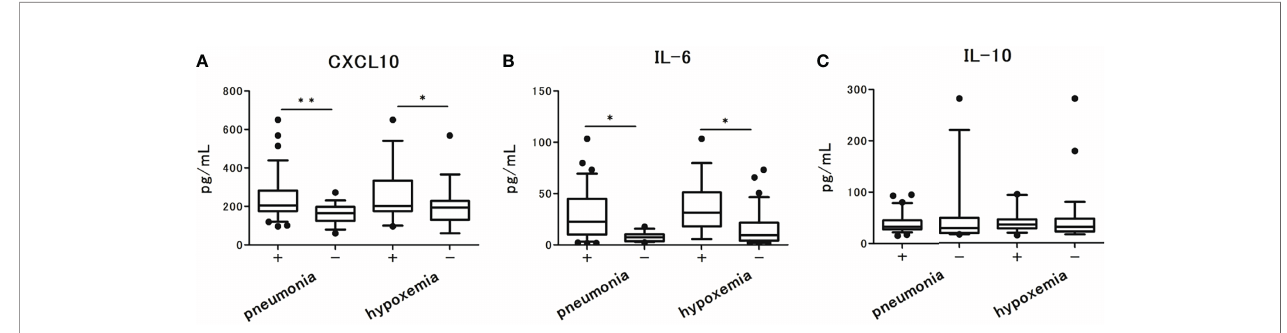
enzyme 2 (ACE-2) by using commercially available ELISA assays, according to the manufacturers ’ instructions ( Supplementary Table 1 ): TNF- a , IL-17, and VEGF (Chondrex, Washington, USA) and ACE-2 (Abcam, Cambridge, UK). However, the analyte signals of TNF- a , IL-17, and ACE-2 were below the background signals in all patients, and those of VEGF were undetectable in 31 patients(62%ofallpatients).Fromtheseresults,wedeterminedthat thelevelsofTNF- a ,IL-17,VEGF,andACE-2weresubstantiallylow